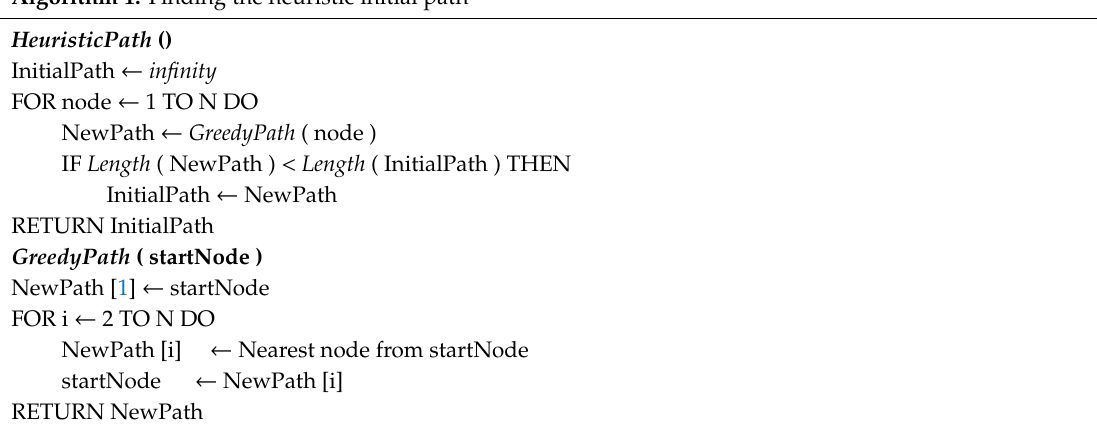
Algorithm 1: Finding the heuristic initial path HeuristicPath